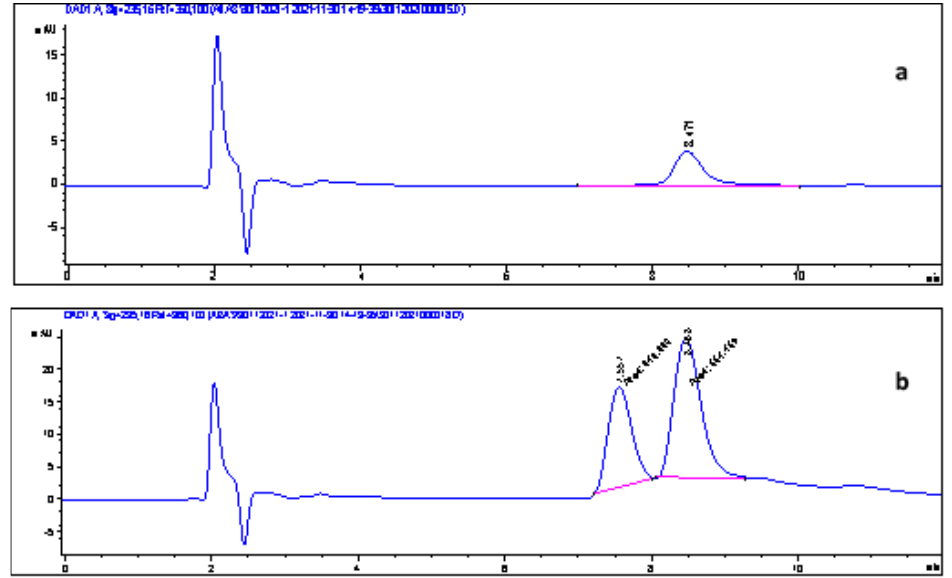
Figure 11. Chromatograms of the juice sample ( a ) and the juice sample spiked with 5 µg mL −1 of BA and SA ( b ). Benzoic acid: 7.5 min; sorbic acid: 8.4 min. Table 9. Recovery percentages (Rs%) of AB and AS from drink